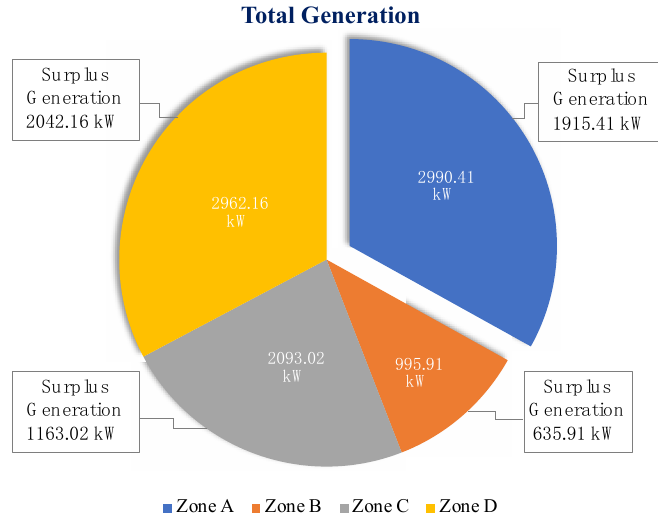
Figure 4. Optimal DERs capacity for Case 2, including surplus generation. Table 3. Optimal Operational Results in Case 2.